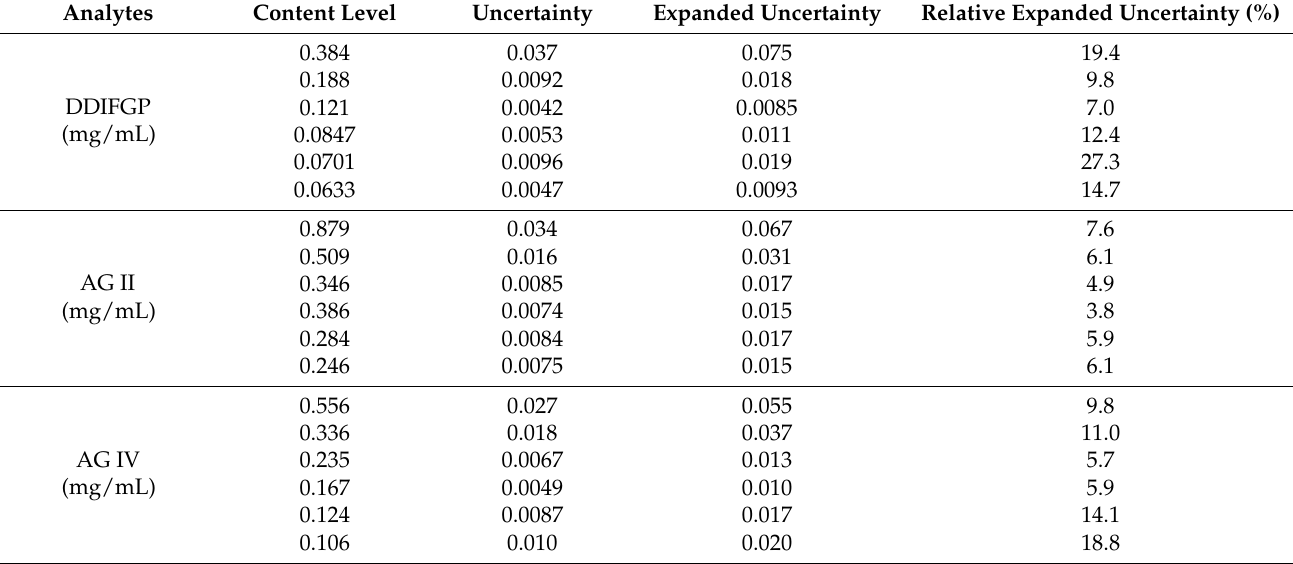
Table 10. NIR method uncertainties for the 7